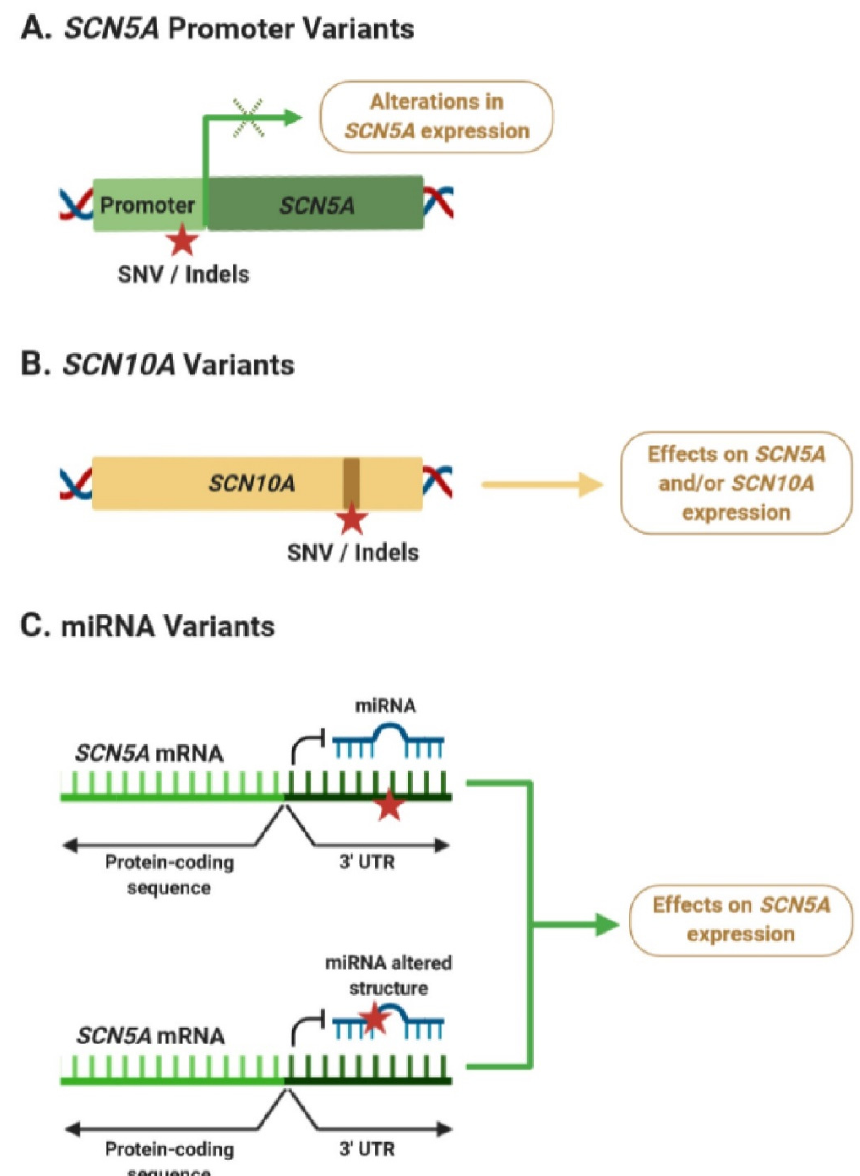
Figure 3. Potential effects of non-coding variants associated with Brugada syndrome (BrS). ( A ) Variants in the SCN5A promoter can lead to alterations in its mRNA expression levels. ( B ) Intronic variants in SCN10A could be affecting SCN5A expression through an enhancer-mediated mechanism or affecting the activity of SCN10A . ( C ) Variants within the 3 ′ untranslated region (UTR) of SCN5A , or affecting the function of BrS-related miRNAs, could lead to dysregulation of SCN5A expression. Red star indicates the position of a new single nucleotide variant (SNV) or an insertion/deletion (Indel). Green × indicates possible alterations of gene expression.